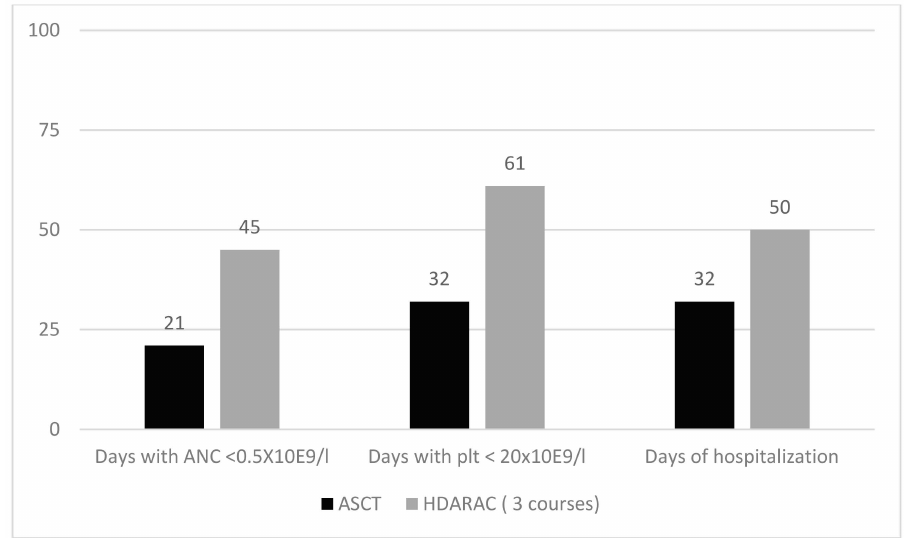
Figure 2. Annual number of allogeneic hematopoietic stem cell transplantations (allo-SCTs) in patients aged 70 years and older by indication: major increase in AML [30,31].